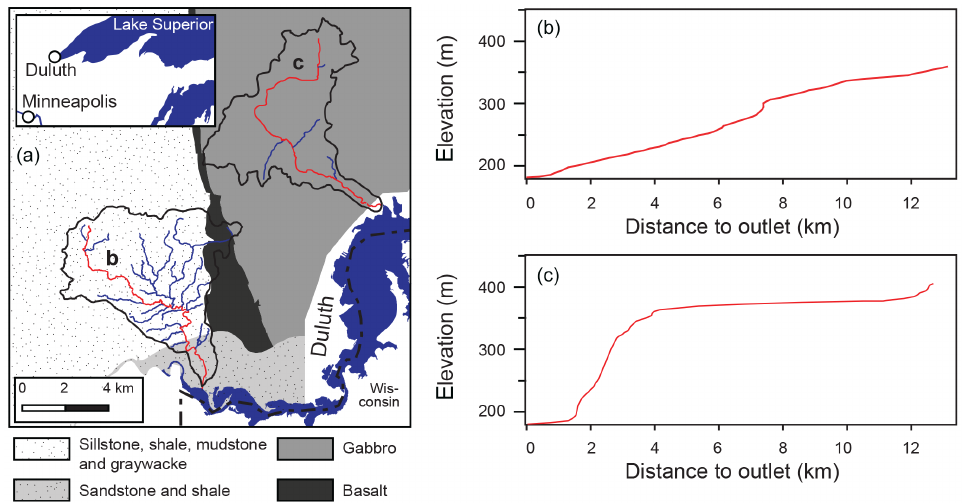
Figure 11. Morpho-geologic map showing two tributaries of the St. Louis River, close to Lake Superior shore, Duluth, Minnesota (a) , and their associated long profiles: the Mission Creek (b) and Kingsbury Creek (c) rivers. Note that while the Kingsbury Creek watershed substrate is resistant gabbro, the substrate of the Mission Creek watershed is composed of loose sedimentary rocks (mainly sillstone, shale, mudstone and sandstone). The white area represents unmapped bedrock, the black line the watershed limit and the dashed line the Minnesota–Wisconsin border. Rivers are in blue. After Fitzpatrick et al. (2006). Vertical exaggeration is 20.